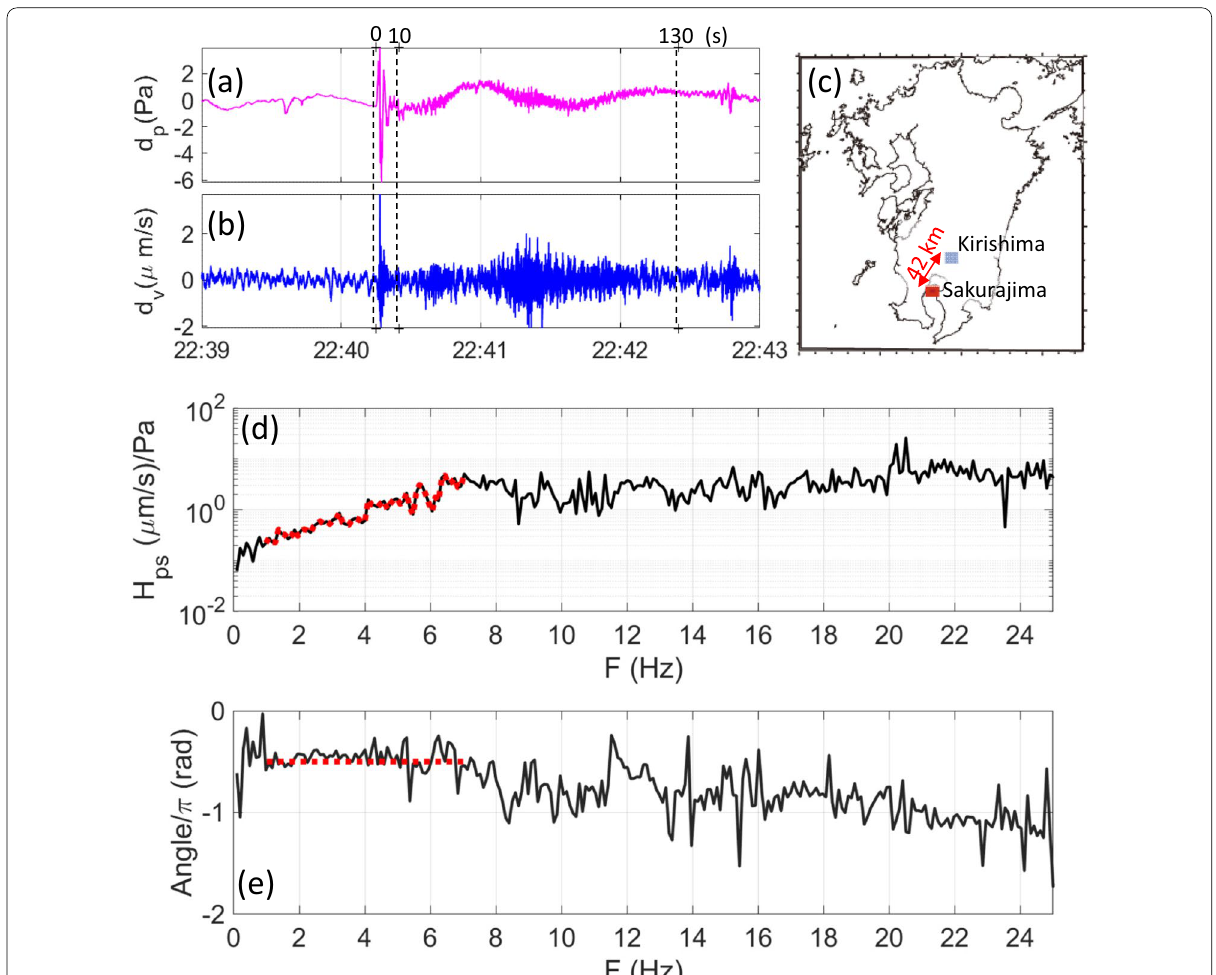
Fig. 1 Infrasound from an explosion, at 22:38 (hh:mm JST) on 13 January 2011, of Sakurajima volcano recorded by an infrasound sensor ( a ) and a broad-band seismometer ( b ) at the SMN station near Kirishima volcano, 42 km to the north of Sakurajima in southern Kyushu, Japan ( c ). The vertical dashed lines in a and b indicate 0, 10, 130 s after the arrival of the explosion signal. The amplitude ( d ) and phase ( e ) response of the ground velocity to incident infrasound at the SMN station. The red dots represent the response function at 1–7 Hz used by Ichihara (2016). All the plots are reproduced from Ichihara (2016), but the phase delay in e has been converted from the range of